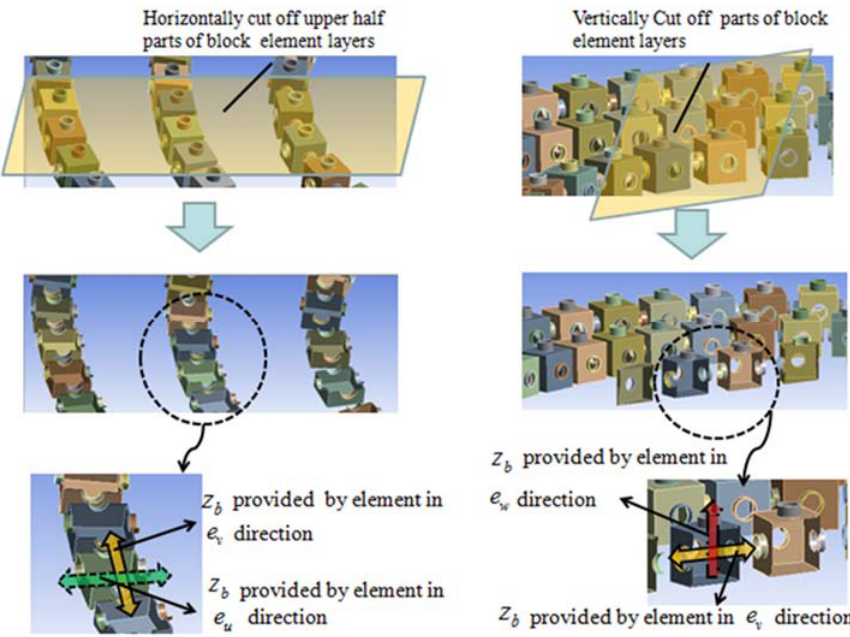
Figure 8. The interior details of the meta ‐ composite material structure. The block elements include